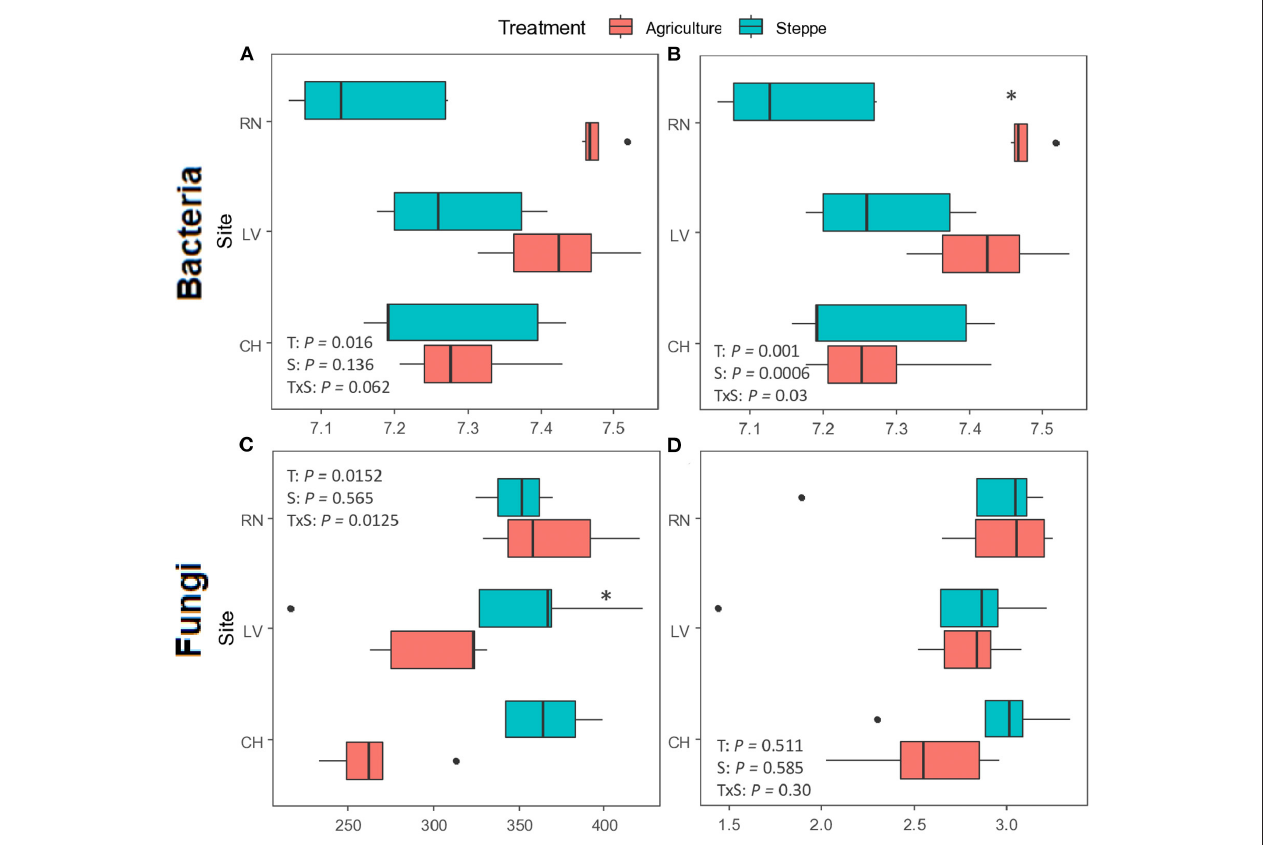
FIGURE 4 | Alpha diversity measures of the bacteria (A,B) and fungi (C,D) communities in irrigated agriculture and steppe. Richness (observed OTUs) and diversity (Shannon-Wiener) indices were evaluated in both treatments ( n = 5). Boxes represent 25–75% of the data, solid lines the median, dots in the box mean, the tips represent the minimum and maximum values excluding the outliers (1.5 times lesser or greater than the lower or upper quantiles) represented by dots outside of the boxes. Data were tested for significance by two-way ANOVA followed by Fisher‘s LSD test. *Denote significant differences between irrigation agriculture and steppe ( p <